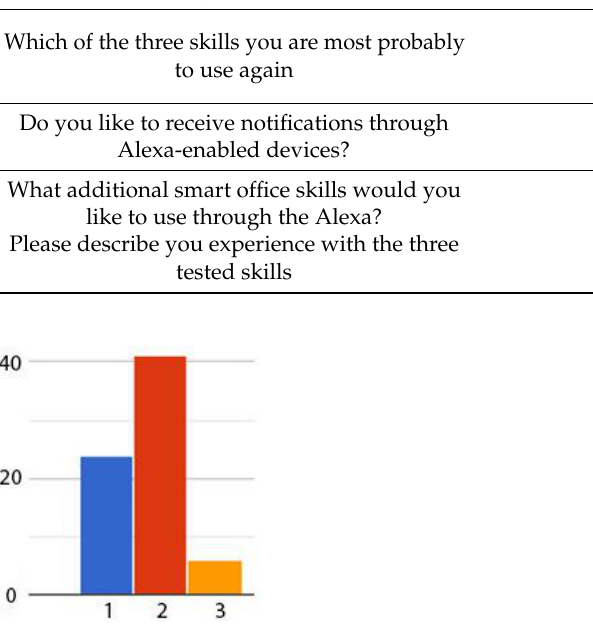
Figure 12. Users’ preferences for the skills.